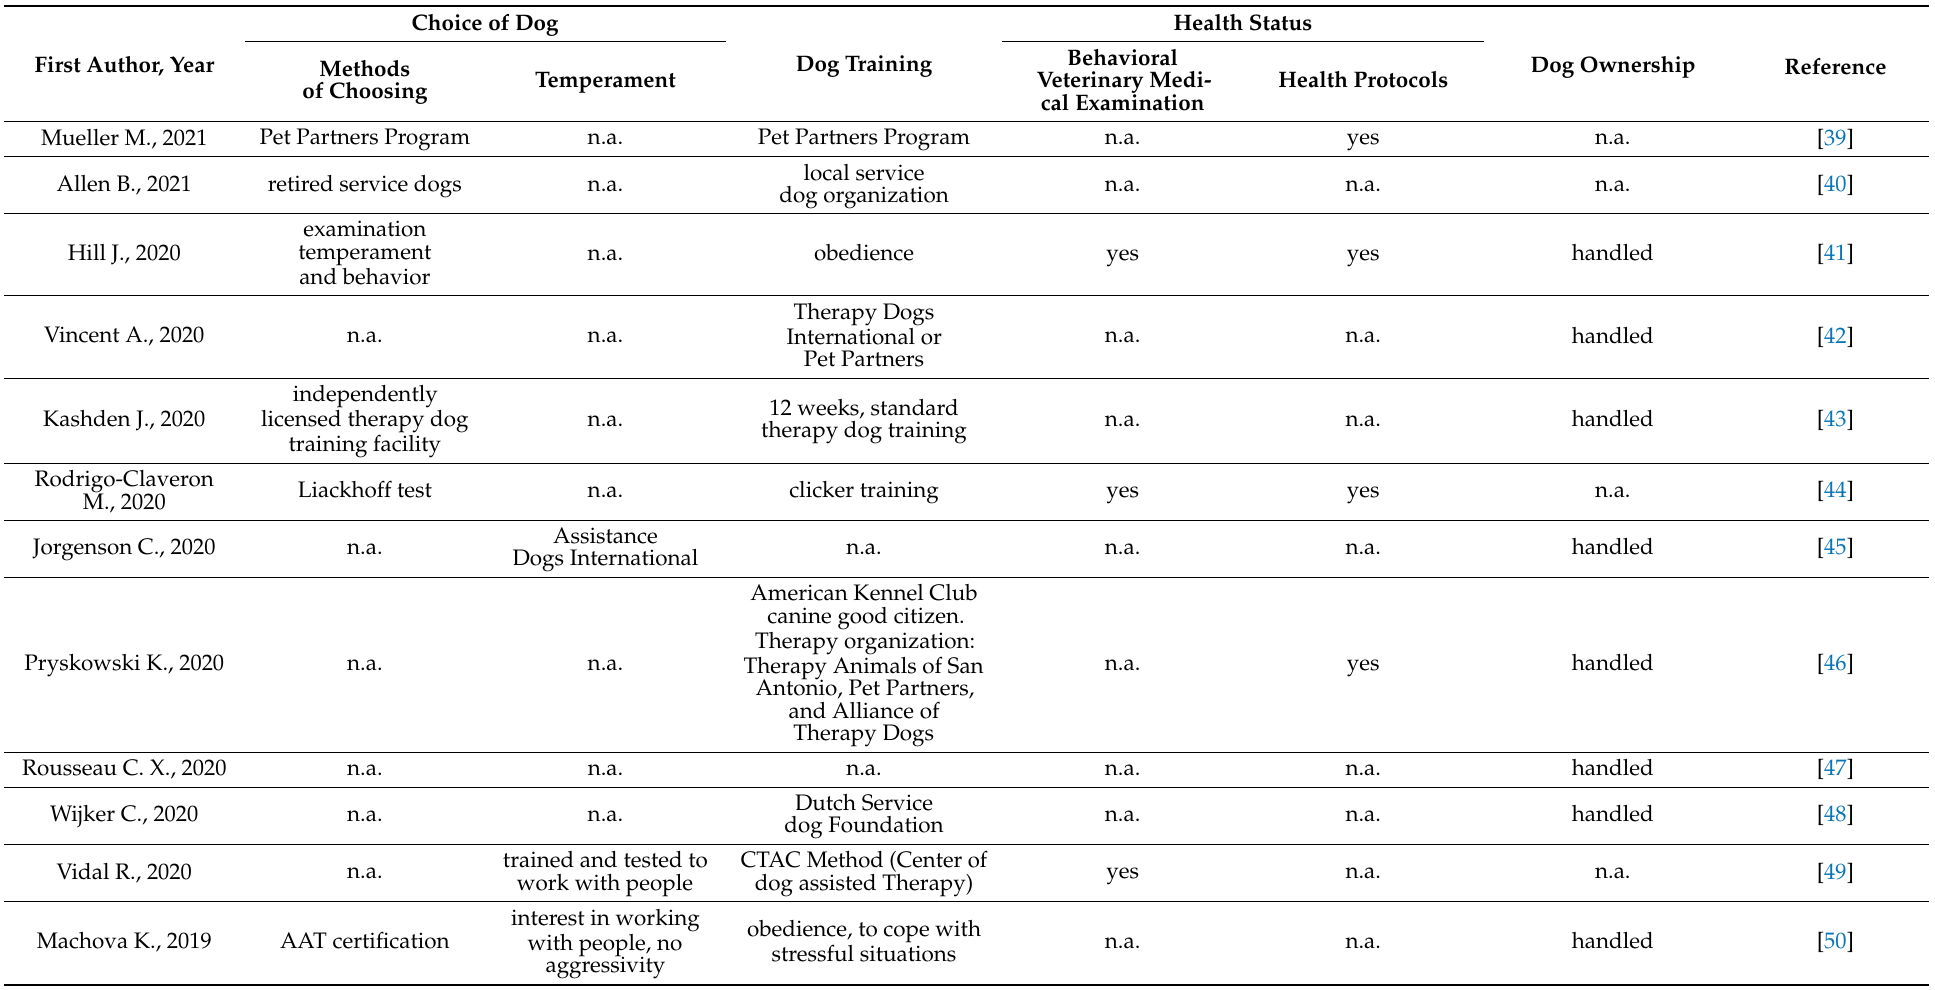
Table 3. Results of information on “Choice of dog”, “Dog training”, “Health Status”, and “Dog ownership” in the included